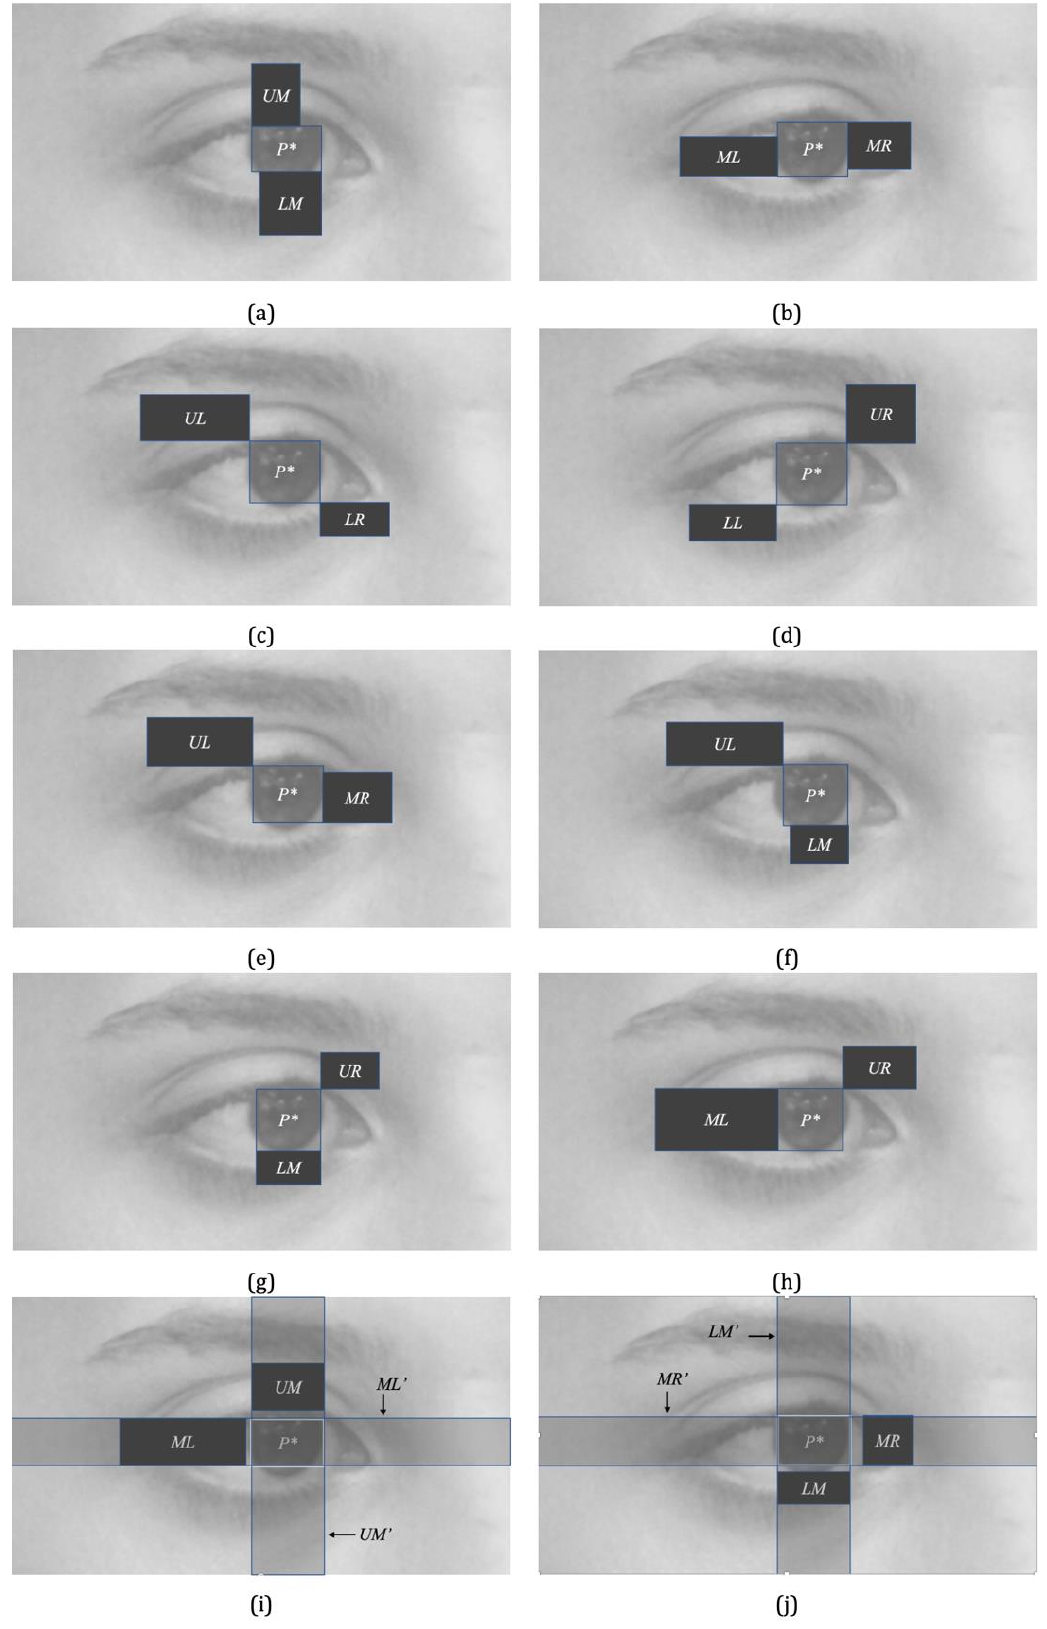
Figure 3. Different cases to estimate P based on using the detected set of